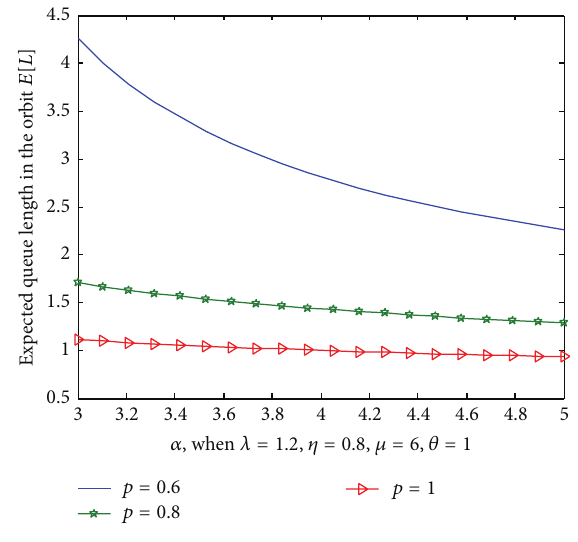
Figure 4: 𝐸[𝐿] with the change of 𝜂 .